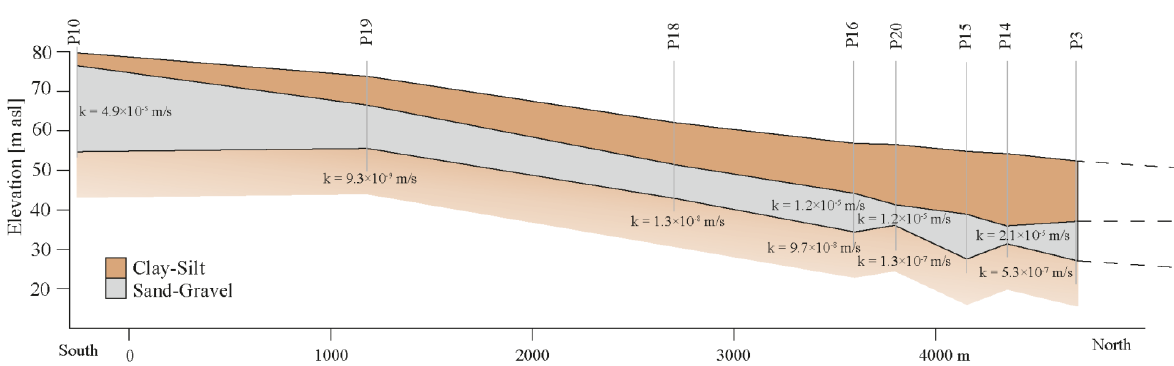
Figure 5. Geological cross section AA’ depicted in Figure 3, k are hydraulic conductivities values (m/s) estimated through pumping or well tests.